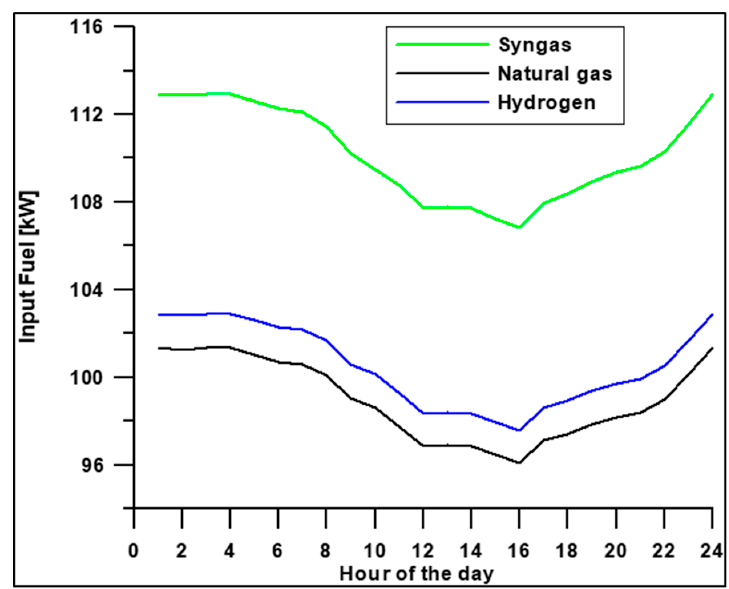
Figure 10. Input fuel power versus day hours.